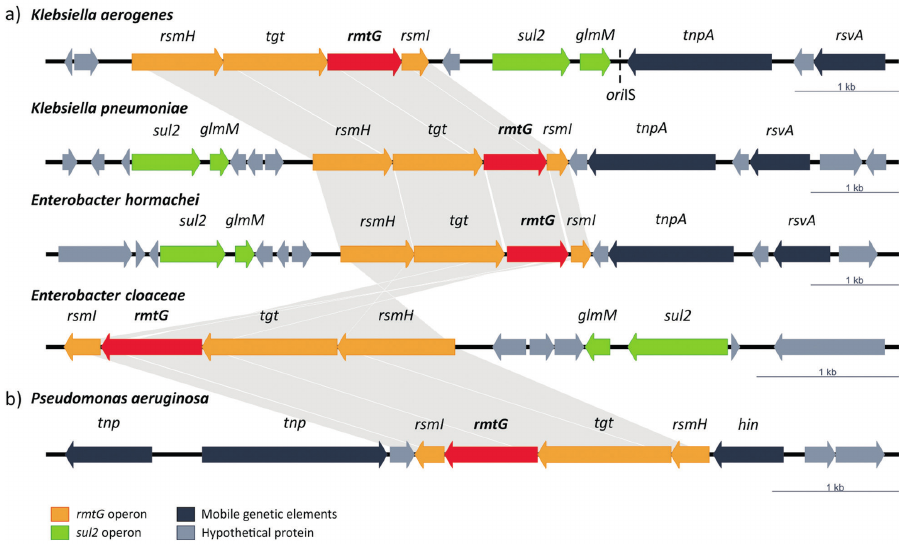
Figure 1 - genetic context of: ( a ) enterobacteriaceae species ( K. aerogenes, K. pneumoniae, E. hormachei and E. cloaceae ) and ( b ) Pseudomonas aeruginosa . Conserved regions are connected by grey shadows. The ori IS represents the start position of the insertion sequence; tnpA encodes a transposase from IS91 family, which has been reported as associated with the accumulation of various resistance genes. It is important to notice that the sul2 operon is absent in the rmtG neighborhood in P. aeruginosa